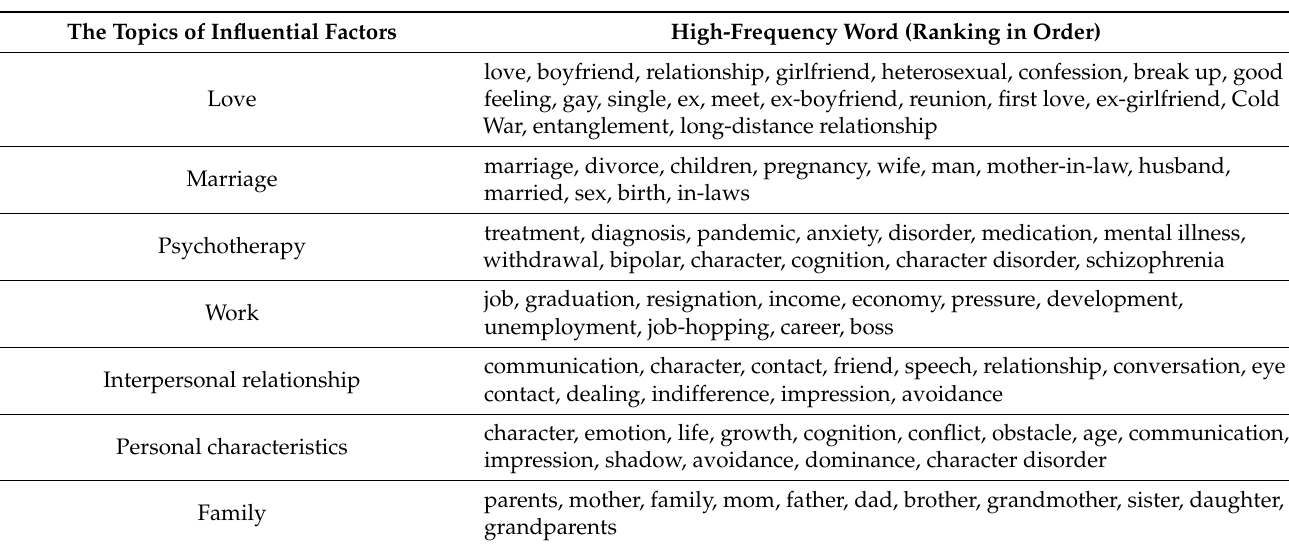
Table 2. Influential factors related to topics of the online PHS